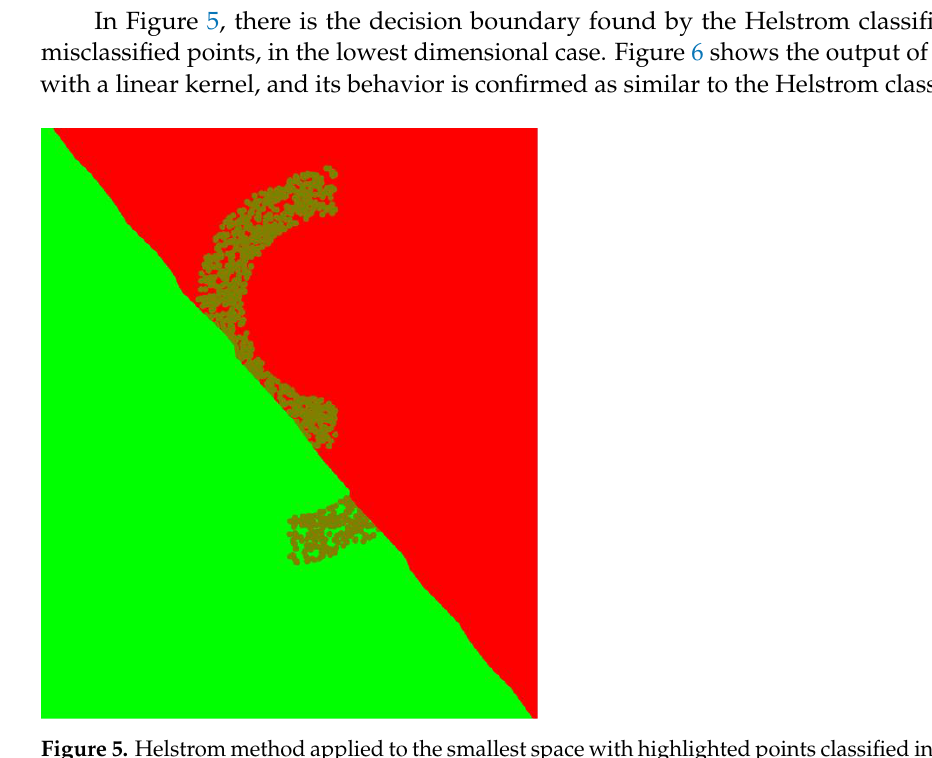
Figure 5. Helstrom method applied to the smallest space with highlighted points classified